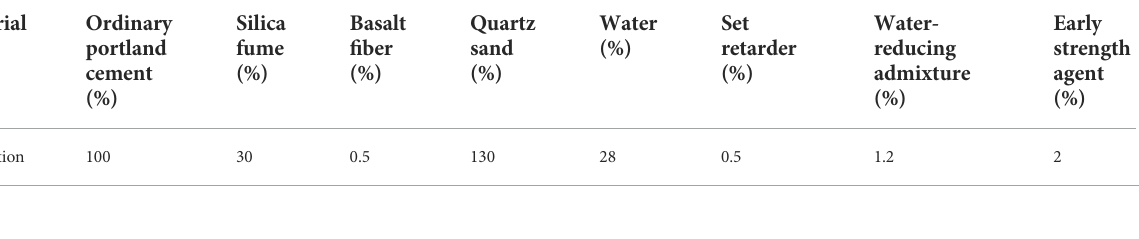
TABLE 2 Speci fi cations of basalt fi ber.